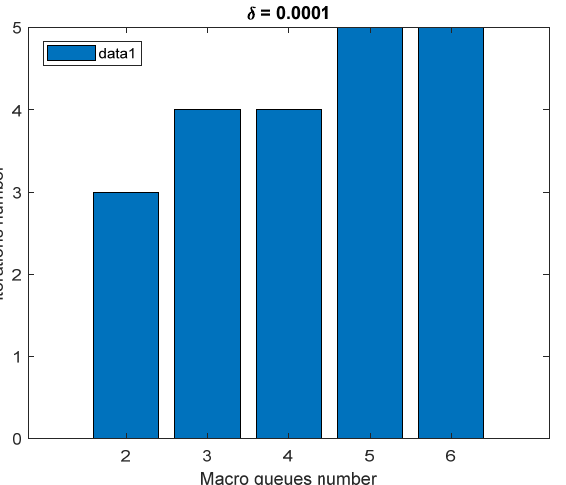
Figure 4. Dependence of coordination procedures (12) and (13) on iteration number required for method convergence to the optimal solution with the number of macro-queues at δ < 0.0001.